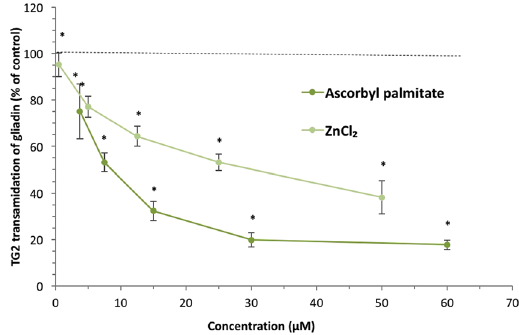
Figure 5. Dose-response experiments (5–60 µ M) of TG2-mediated transamidation of wheat gliadin biotin (to biotin) in the presence of ascorbyl palmitate and ZnCl 2 separately. Data are presented as means ± SD (n = 3). The asterisk indicates a significant change compared to control (p < 0.05).